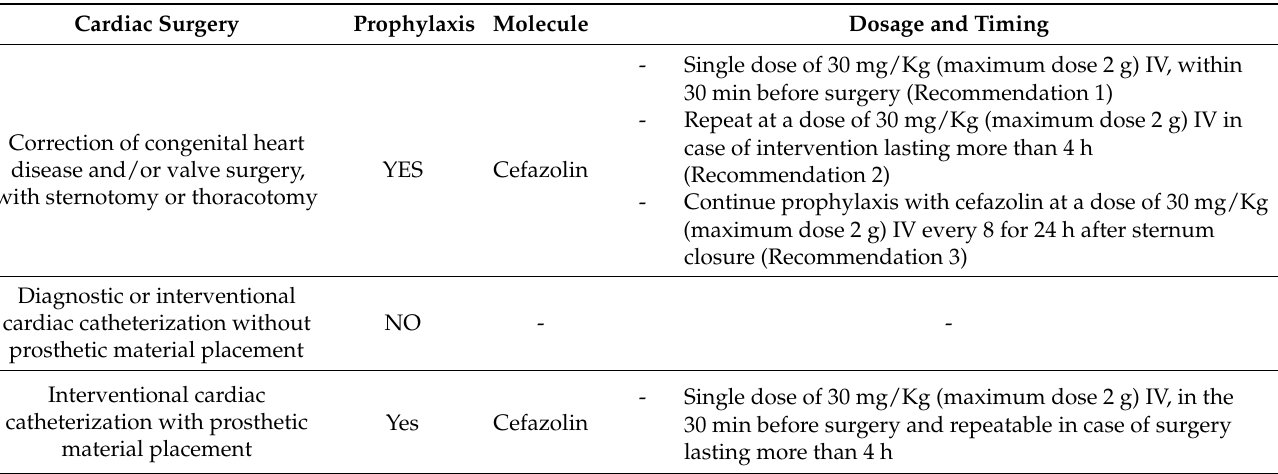
Table 4. Summary of recommendations for cardiac